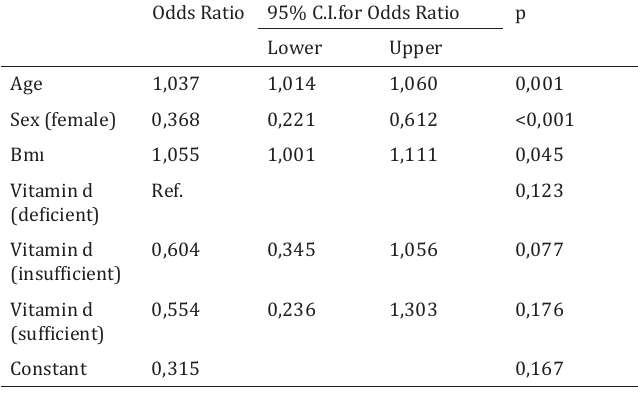
Multiple Binary Logistic Regression between Mild+moderate+severe OSAS with simple OSAS